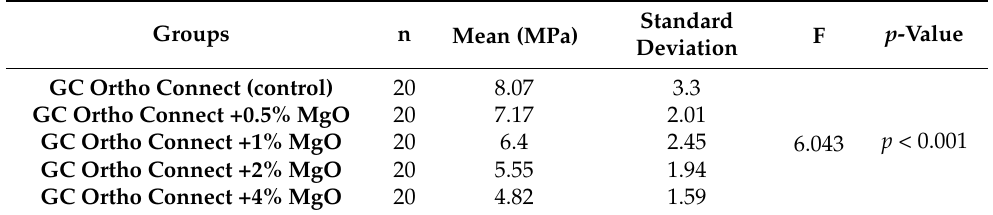
Table 1. Mean and standard deviation of the SBS in five different groups.